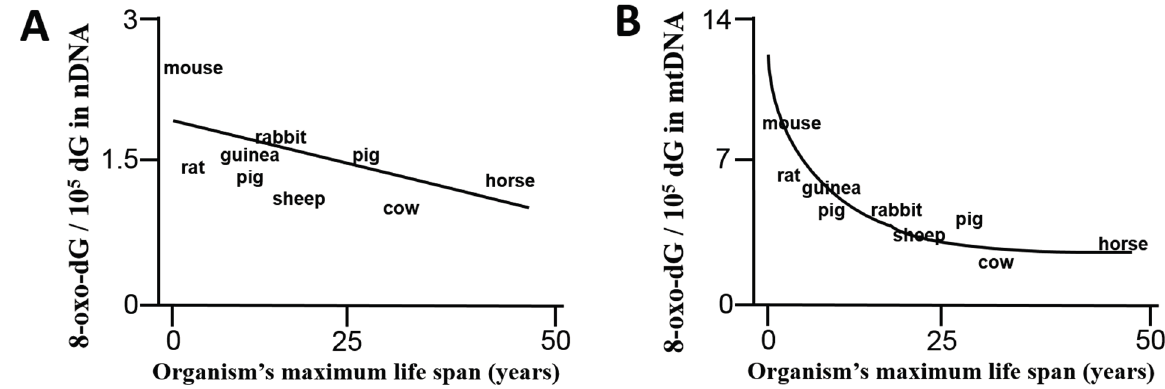
Figure 6. Correlation of an organism’s life span with the content of 8-oxo-dG in nuclear ( A ) or mitochondrial ( B ) DNA in cardiac tissue. Surprisingly, oxidative DNA lesions do